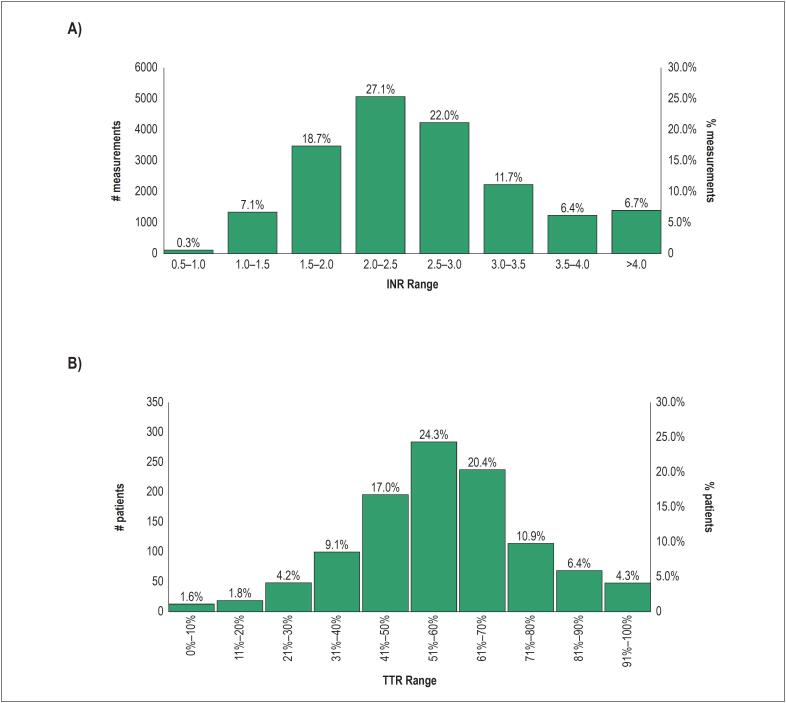
INR and TTR results. A. Measurement distribution per INR range. B. Patient distribution per TTR range.